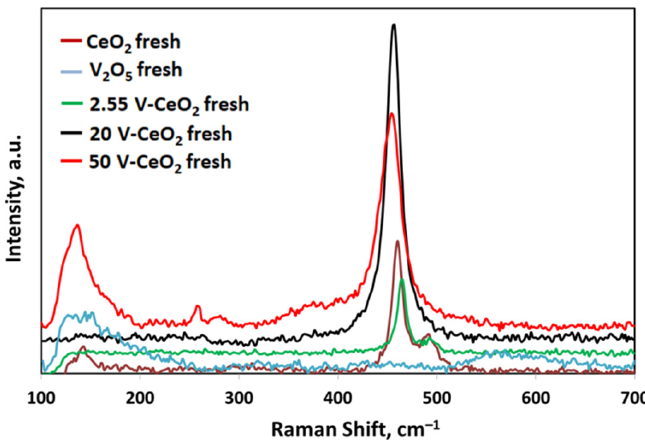
Figure 6. Raman spectra of CeO 2 , V 2 O 5 , and 2.55, 20, 50 V-CeO 2 fresh catalysts.